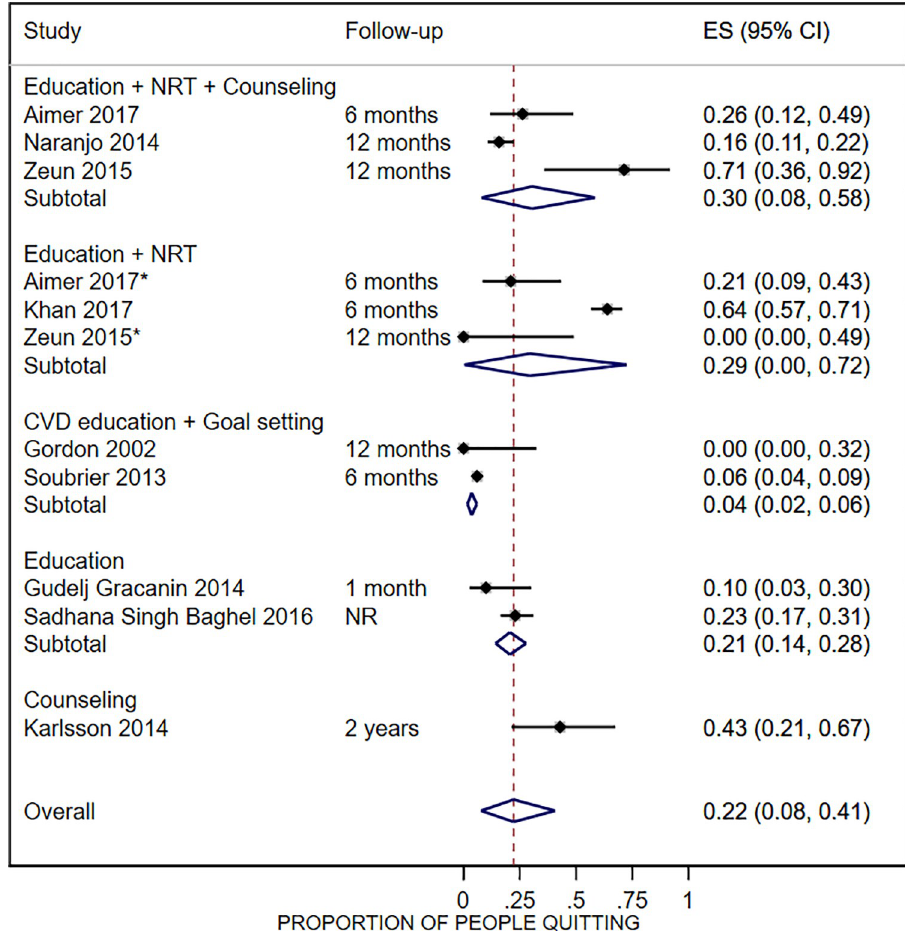
Fig 2. Self-reported smoking cessation rates. � Smoking cessation rates for Aimer 2017 and Zeun 2015 are reported for the intervention and control group in separate rows because both strategies provided smoking cessation services. In the control group in Zeun 2015, patients were referred to their general practitioner for smoking cessation services. ES, effect estimate (proportion of people quitting); CI, confidence interval; NRT, nicotine replacement therapy; CVD, cardiovascular disease. Inconsistency scores for the subgroups (I 2 ): Education+NRT+Counseling = 80.2%; Education +NRT = 90.3%; CVD education+Goal setting = 0%; Education = 0%; Counseling = not